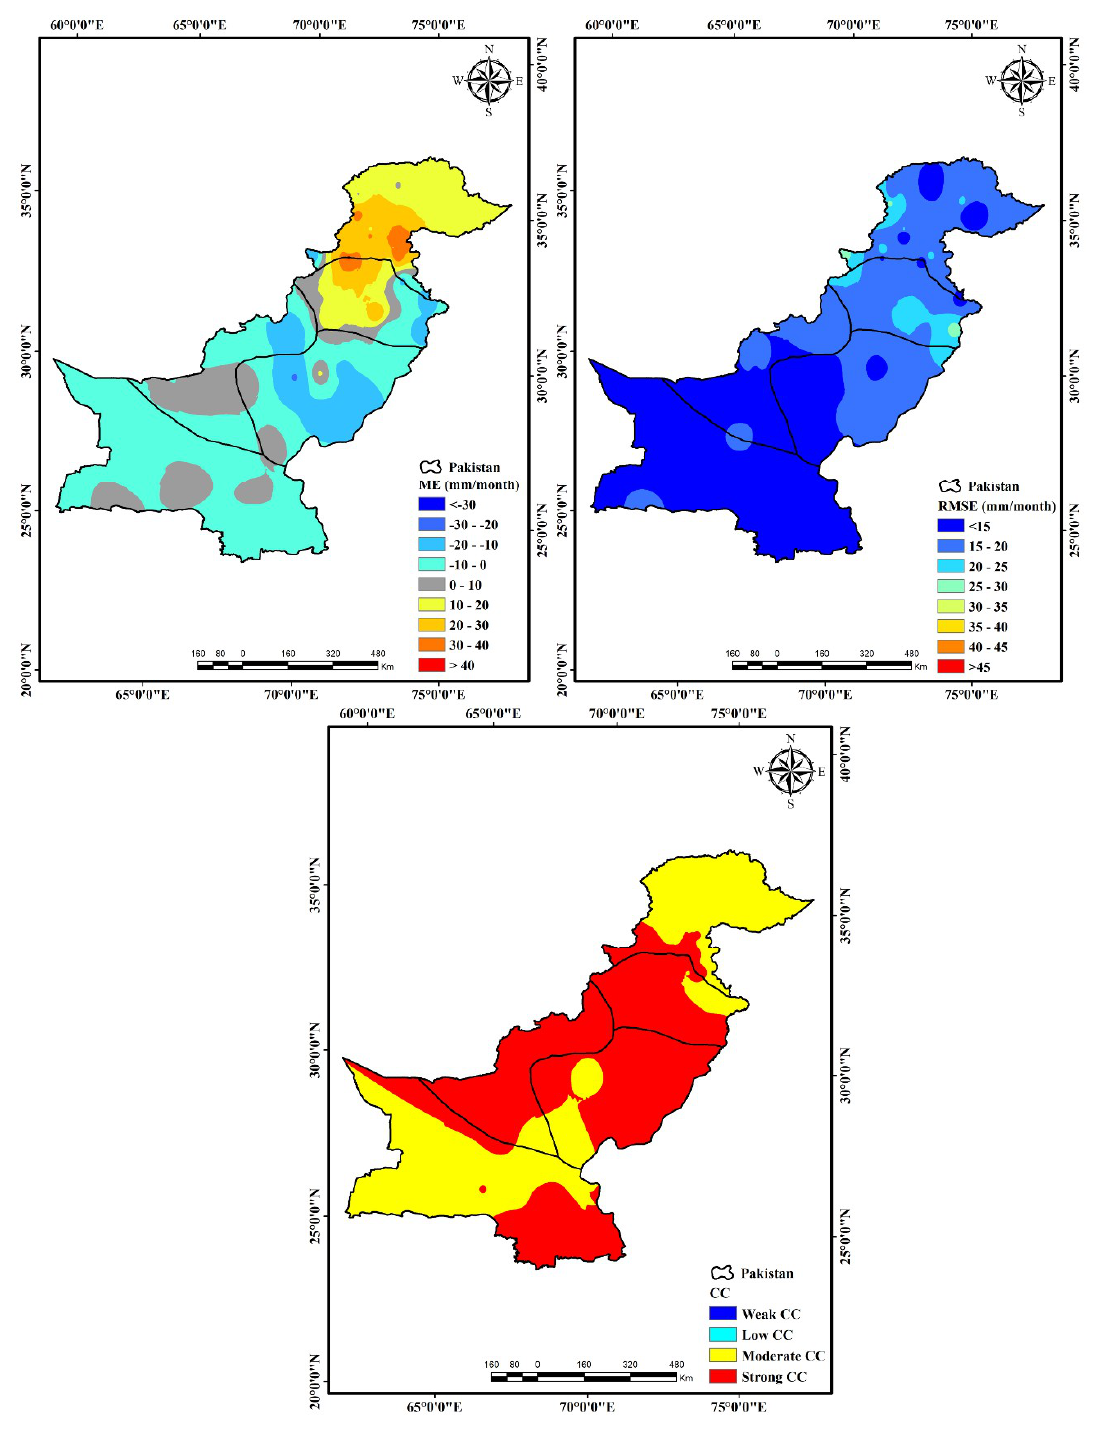
Figure 3. EP algorithm evaluation.